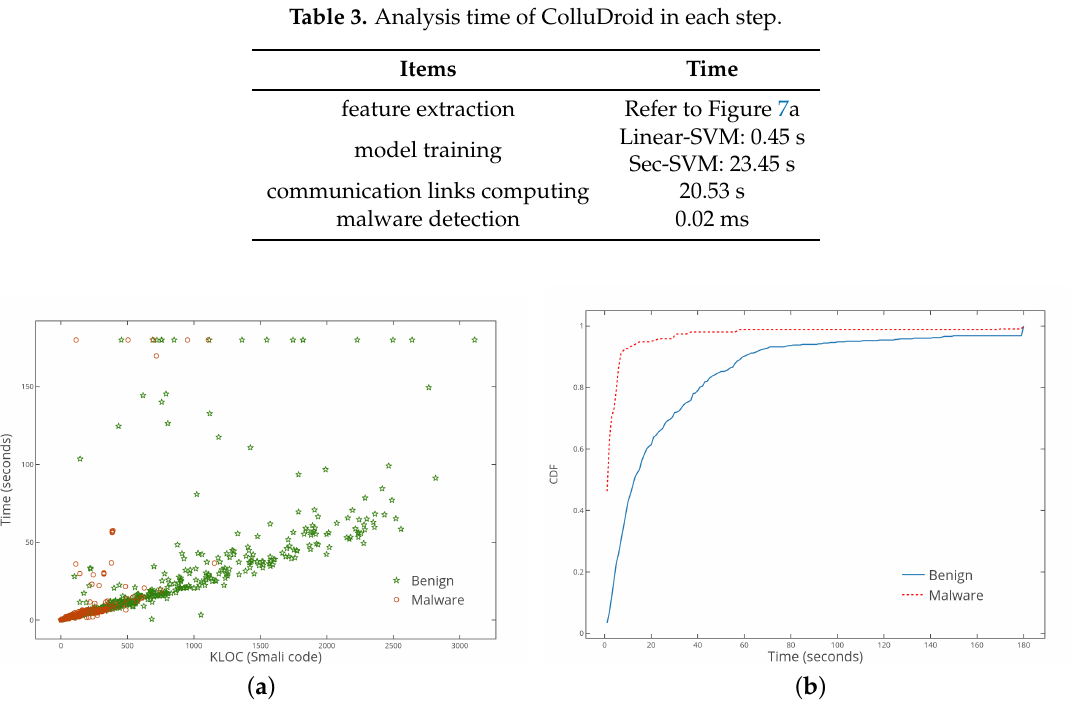
Figure 7. Feature extraction time of ColluDroid. ( a ) feature extraction time; ( b ) cumulative distribution function.